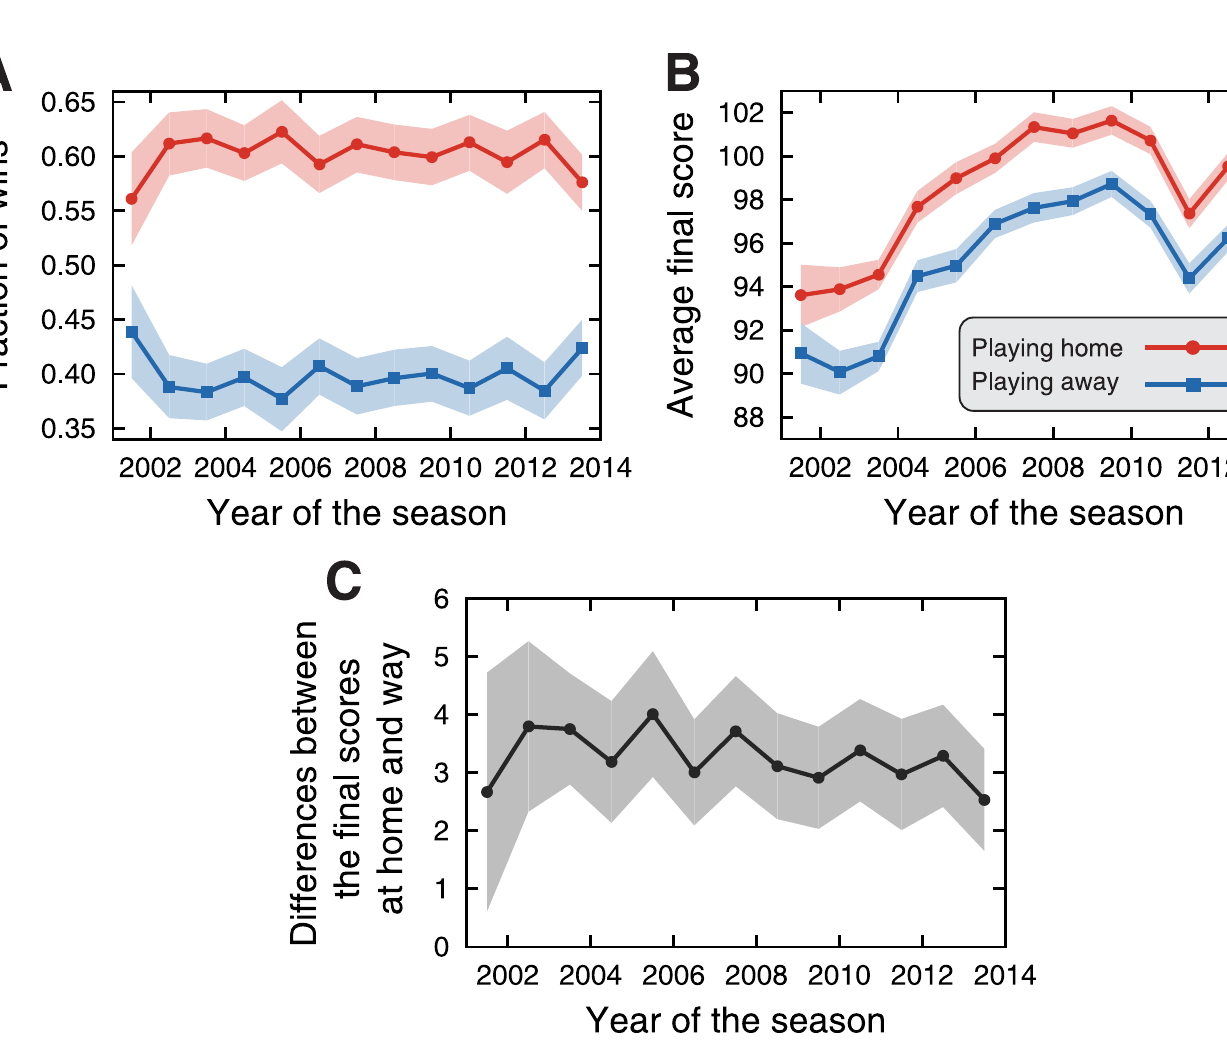
Fig 1. Macroscopic manifestation of the home advantage in NBA. (A) Average fraction of wins when playing home (red circles) and away (blue squares) along the thirteen NBA seasons studied here. (B) Average final score of the teams when playing home (red circles) and away (blue squares). (C) Evolution of the differences between the final scores and at home and away along the NBA seasons. In all plots, the shaded areas stand for 95% bootstrap confidence intervals.